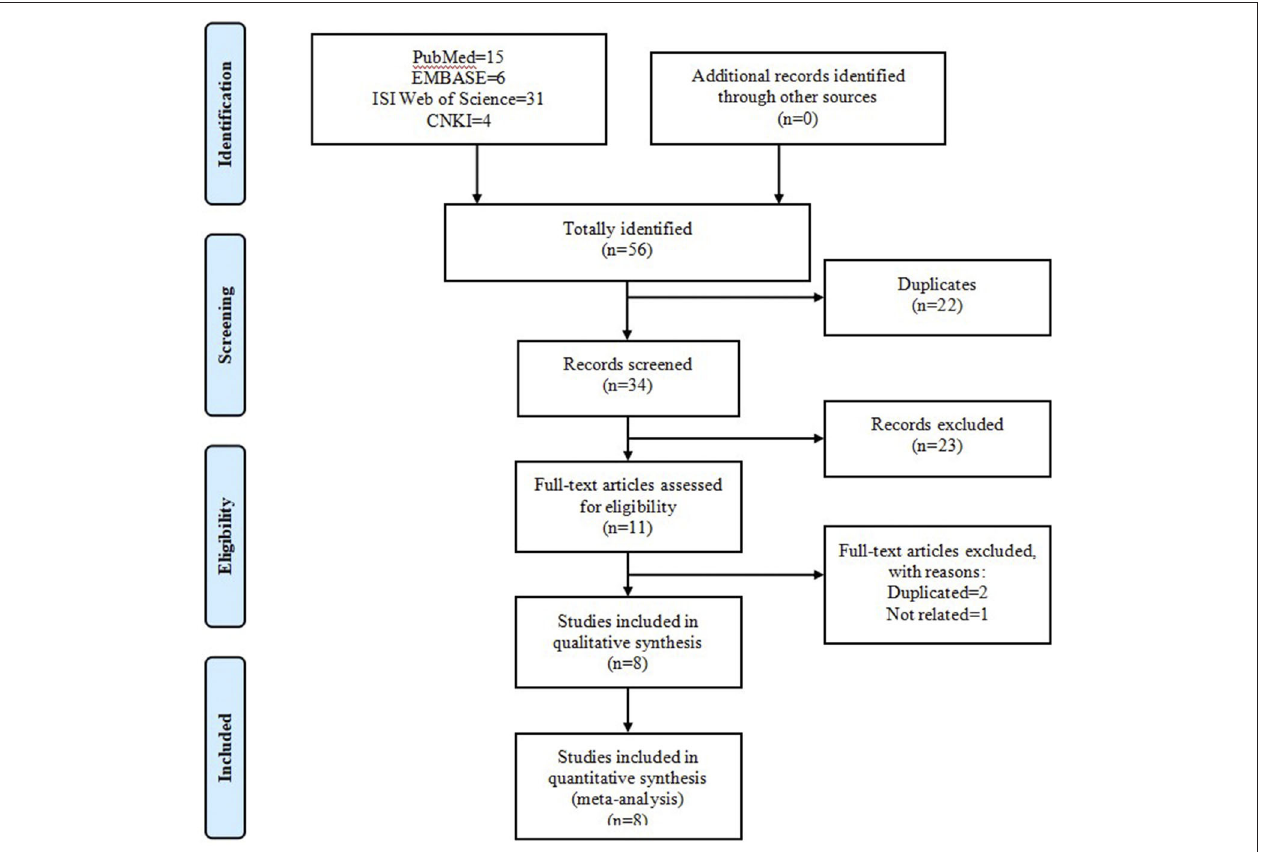
FIGURE 2 | Flow chart of literature search and